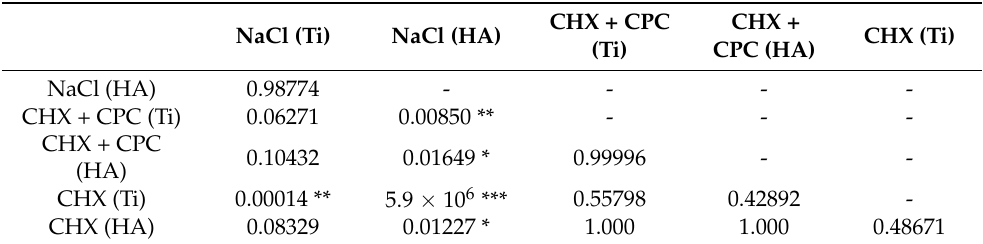
Table 1. A multiple comparison test (Nemenyi post hoc test) was performed to compare the groups after 24 h of in situ plaque collection.